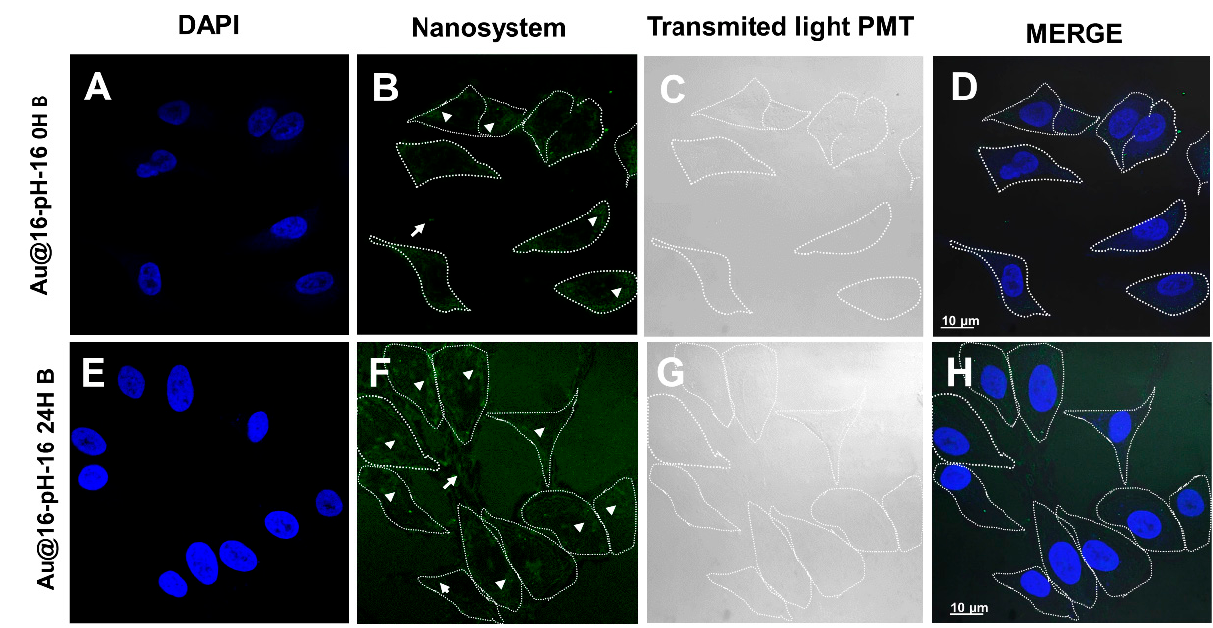
Figure 12. Confocal photomicrographs showing BJ-hTERT cells treated with free nanoparticle N 3 Au@16-pH-16 at 0 h ( A – D ) and 24 h after treatment ( E – H ). ( A , E , D , H ) the cell nuclei labeled with fluorochrome DAPI. The presence of nanoparticles with fluorescence is shown in ( B , F ) and with transmitted light in ( C , G ). ( D – H ) show the result of the merge. Dashed lines mark the cell contours. Arrows indicate nanoparticles on the cell exterior, and arrow heads show nanoparticles internalized in cells.